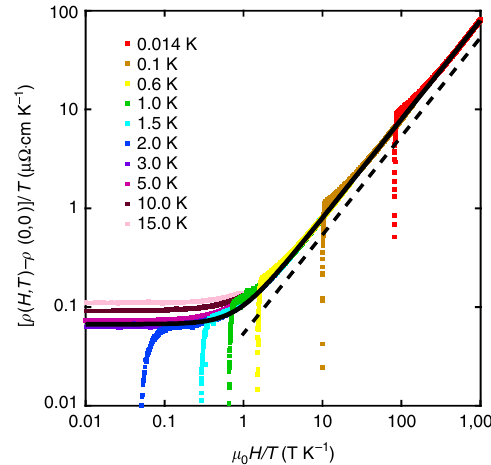
Figure 4 | H – T scaling in CrAs at 13.1kbar. The magnetoresistance replotted as [ r ( H , T ) (cid:2) r (0, 0)]/ T against m 0 H / T . The data below 3.0K can all be described by a single curve A (1 þ Bx 2 ) 0.5 (thick solid curve), which has the same functional form as equation (3). Note that the axes are on logarithmic scales, and the dashed line indicates a unity